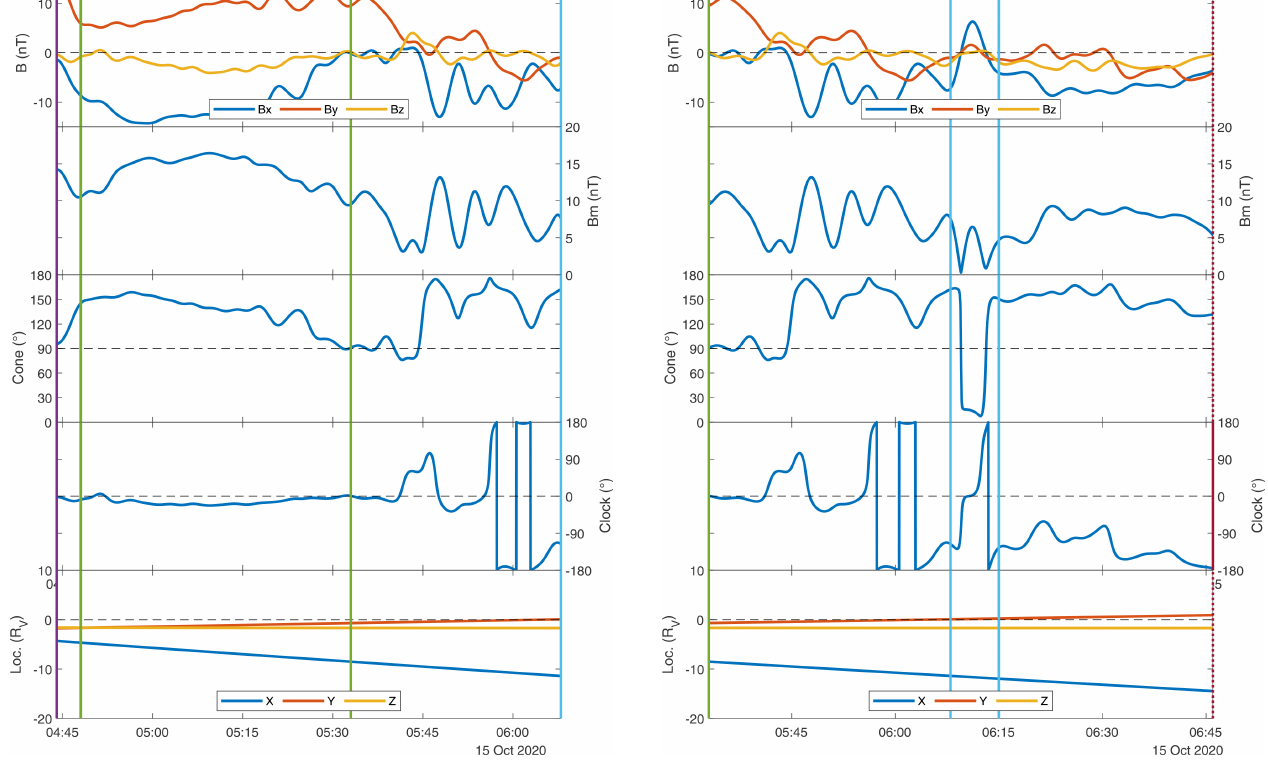
Figure 5. Zoom-in on the time interval (green) when BepiColombo is in the magnetotail proper. This interval shows a strongly draped field with θ x ≈ 150 ◦ , with a strong B y component.